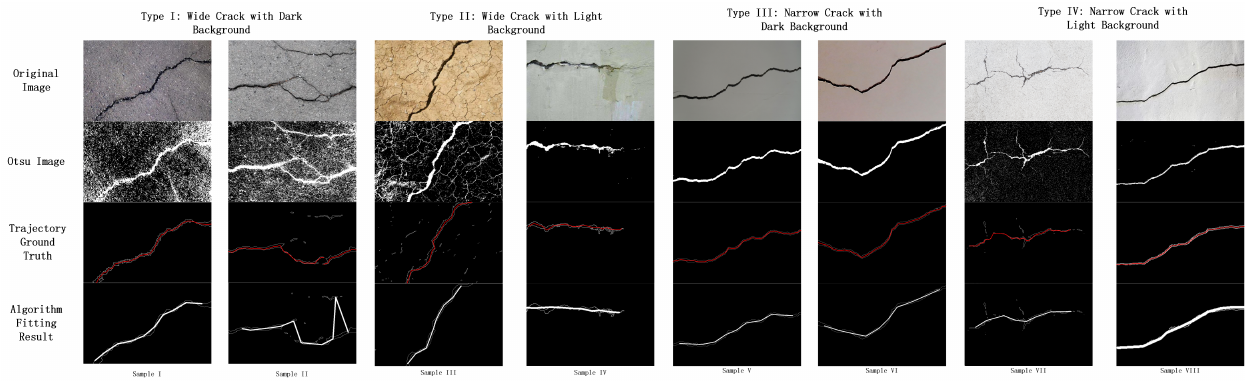
Figure 18. Dataset fitting